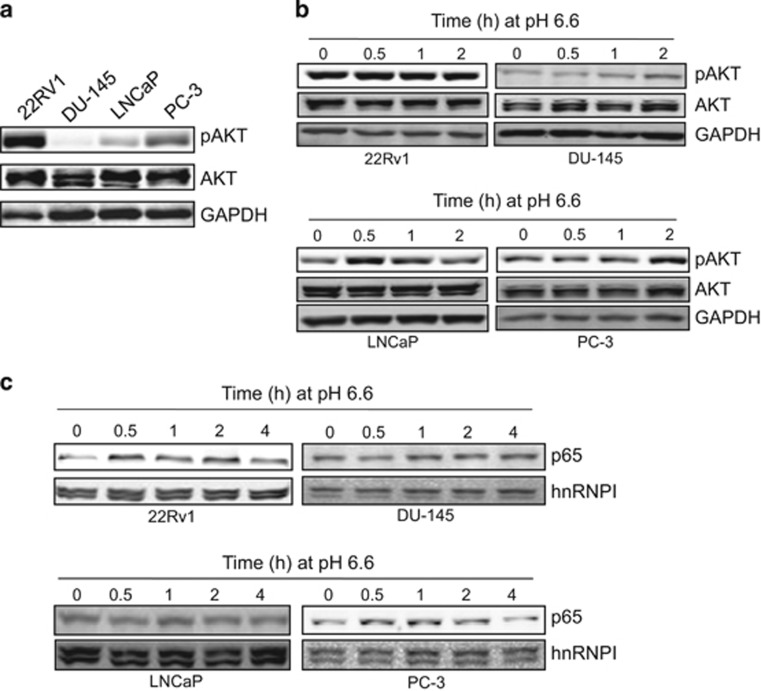
Acidosis induces nuclear translocation of NF-κB. (a), Expression of pAKT in 22Rv1, DU-145, LNCaP and PC-3 cells, as detected by western blot. (b) Detection of acidosis-induced AKT in selected prostate cancer cells. Note that no AKT activation is seen in 22Rv1 cells. (c) Nuclear localization of NF-κB in prostate cancer cells in response to acidosis. ‘Time 0 h' indicates that the cells were cultured at pH 7.4.